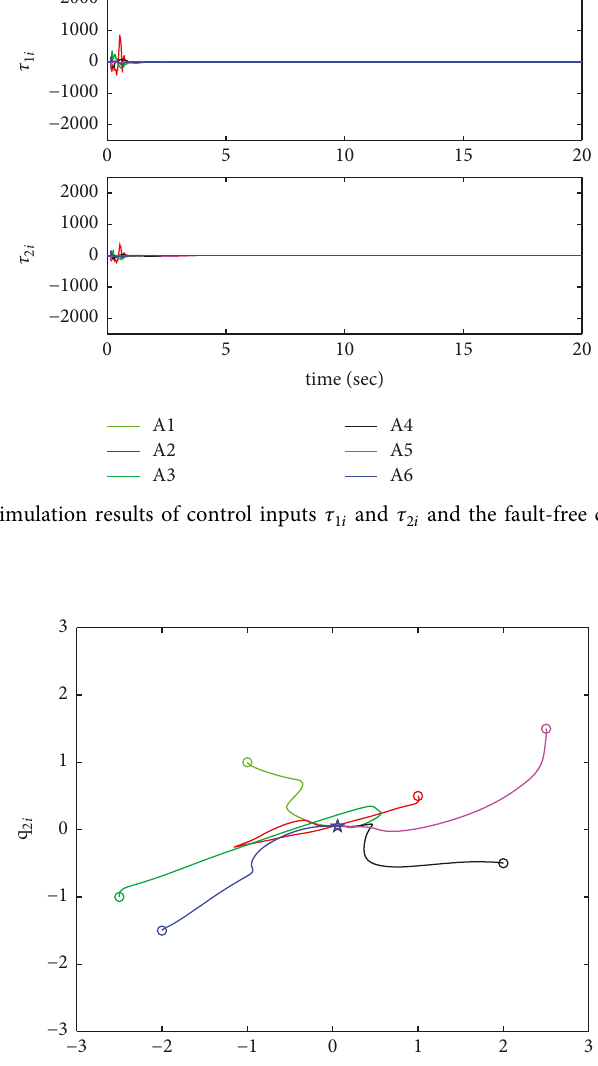
Figure 7: Multiagent trajectories and the fault-free case